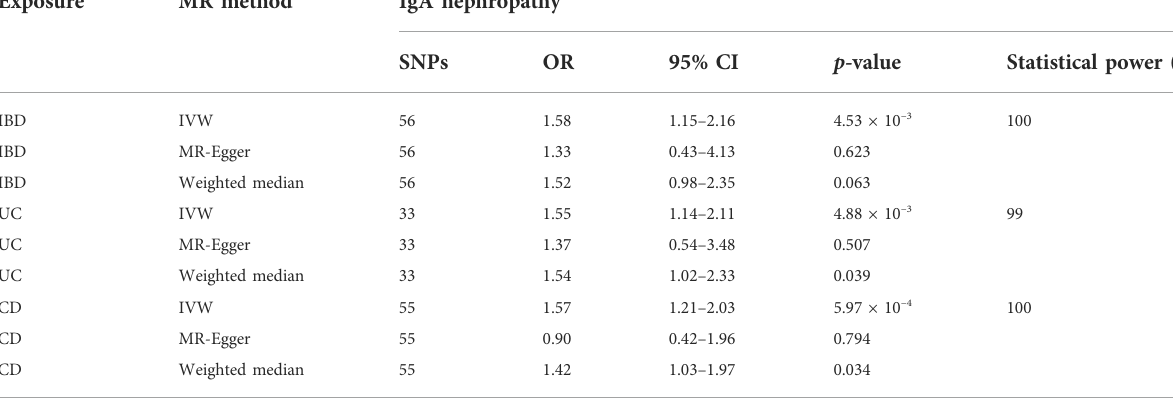
TABLE 1 Causal effects of IBD, UC, and CD on IgA nephropathy based on MR. Exposure